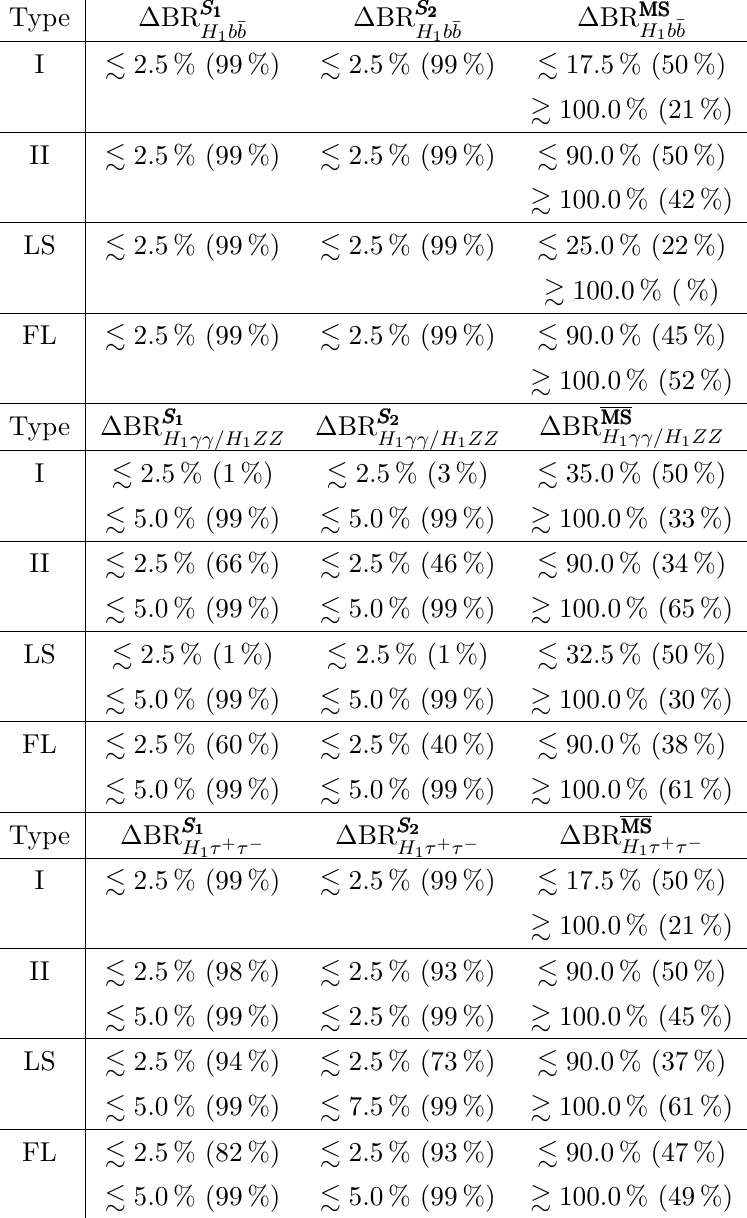
Table 16 . Relative size of the EW corrections to the BRs of the N2HDM SM-like H 1 in the